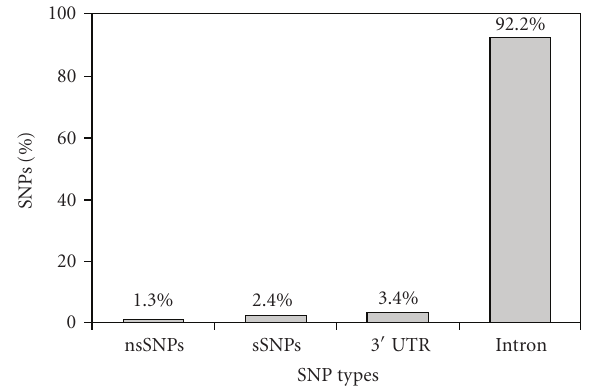
Figure 1: Distribution of IGF1R non-synonymous SNPs (nsSNPs), synonymous SNPs (sSNPs), 3 (cid:2) UTR SNPs, and intronic